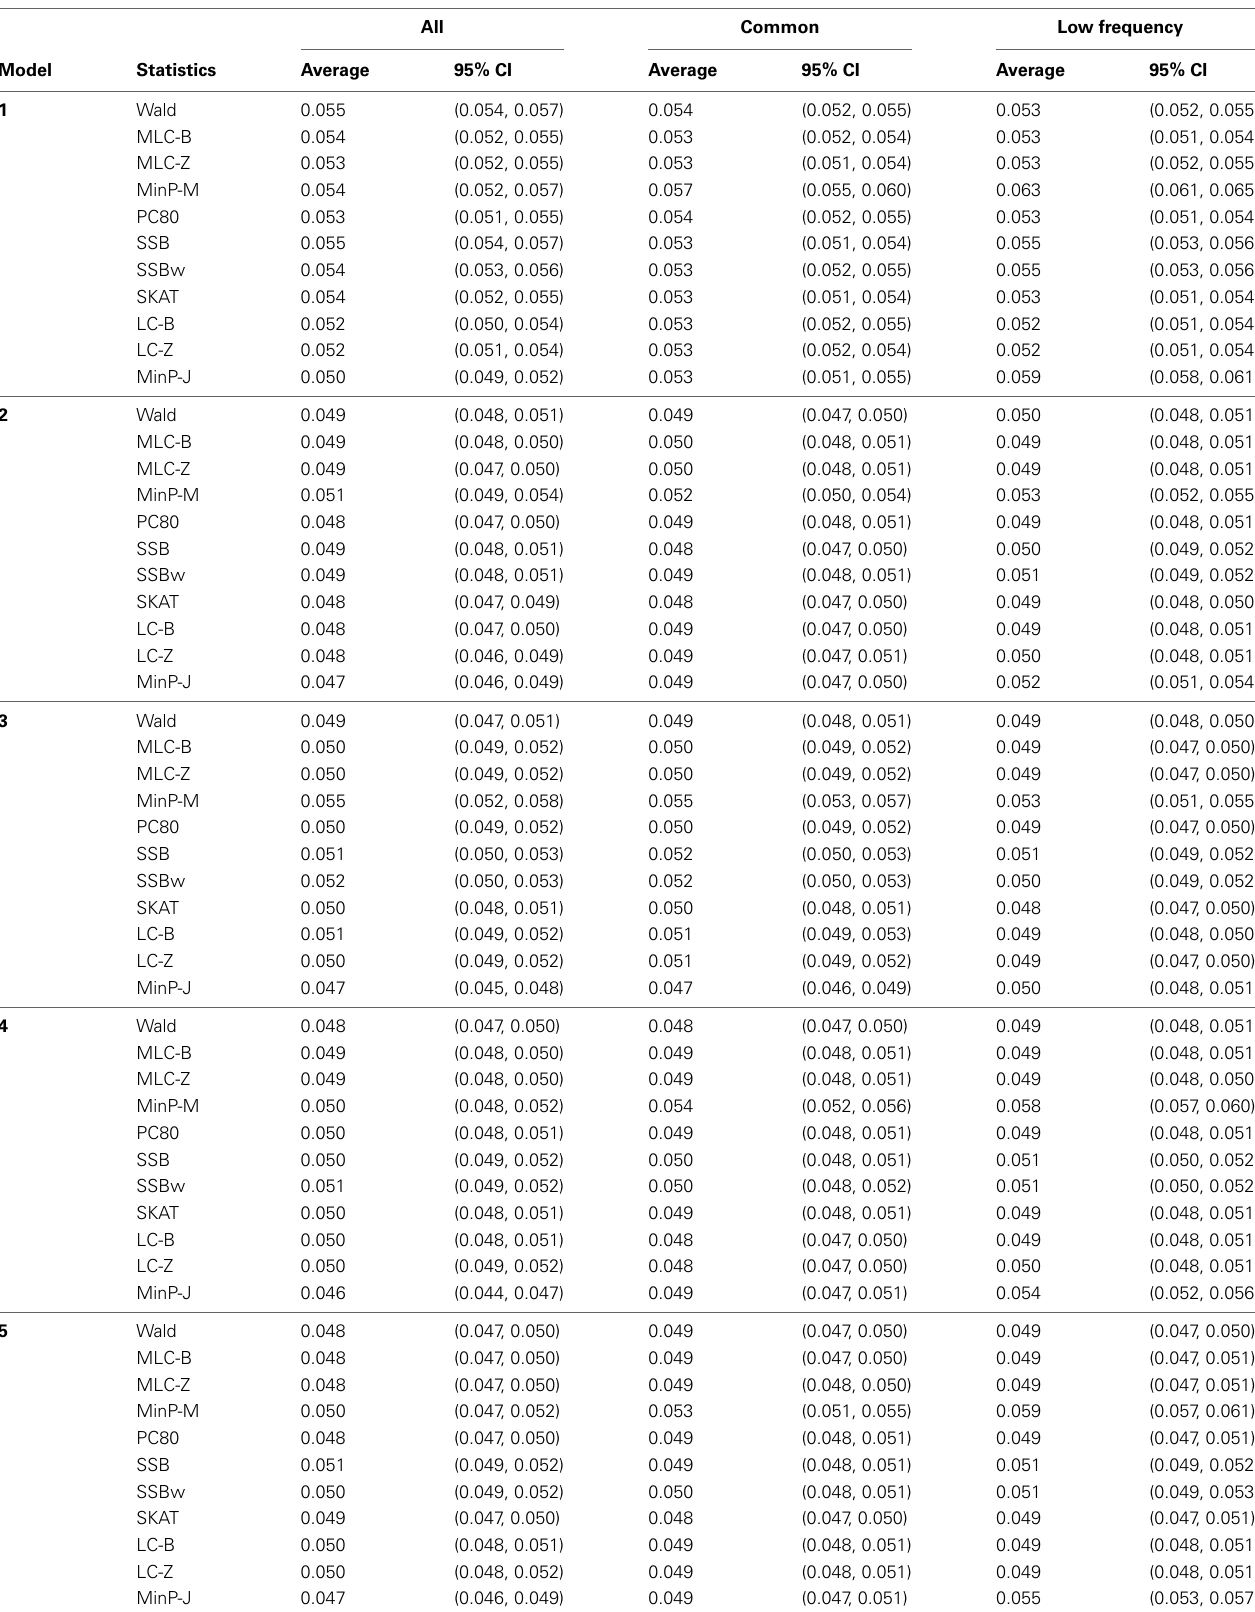
Table 4 | Empirical type I error of gene-based statistics ( N = 1000 replicates) at the 0.05 level for three analysis sets, averaged over 85